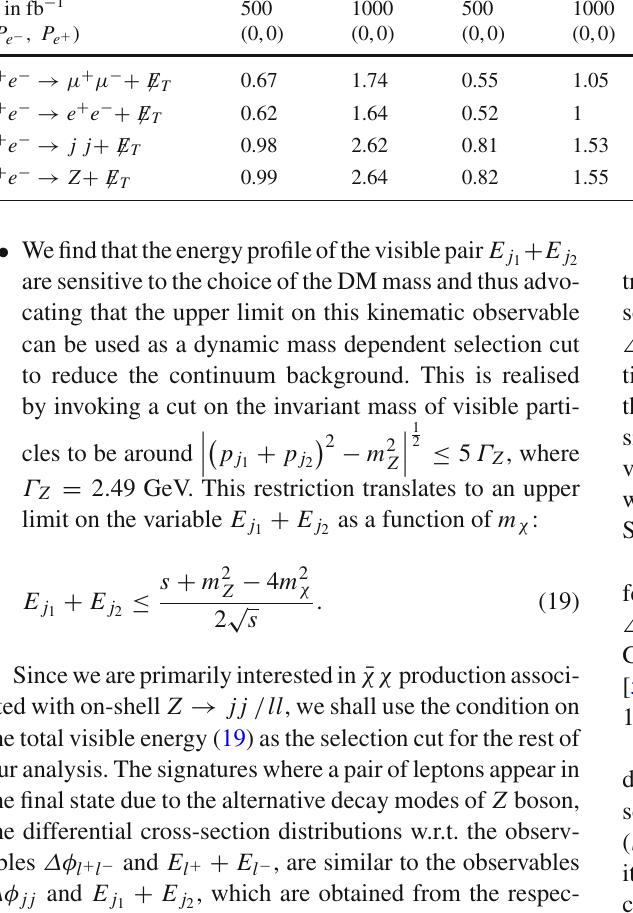
Table3 Estimationof3 σ sensitivityreachofthemaximumvalueofthe cut-off Λ max . in TeV for m χ = 20 GeV that can be probed in ILC at = 500 GeV and 1 TeV with an integrated luminosity L = 500 fb − 1 and L Unpolarised Polarised Interactions S–S V–V S–S V–V √ s in